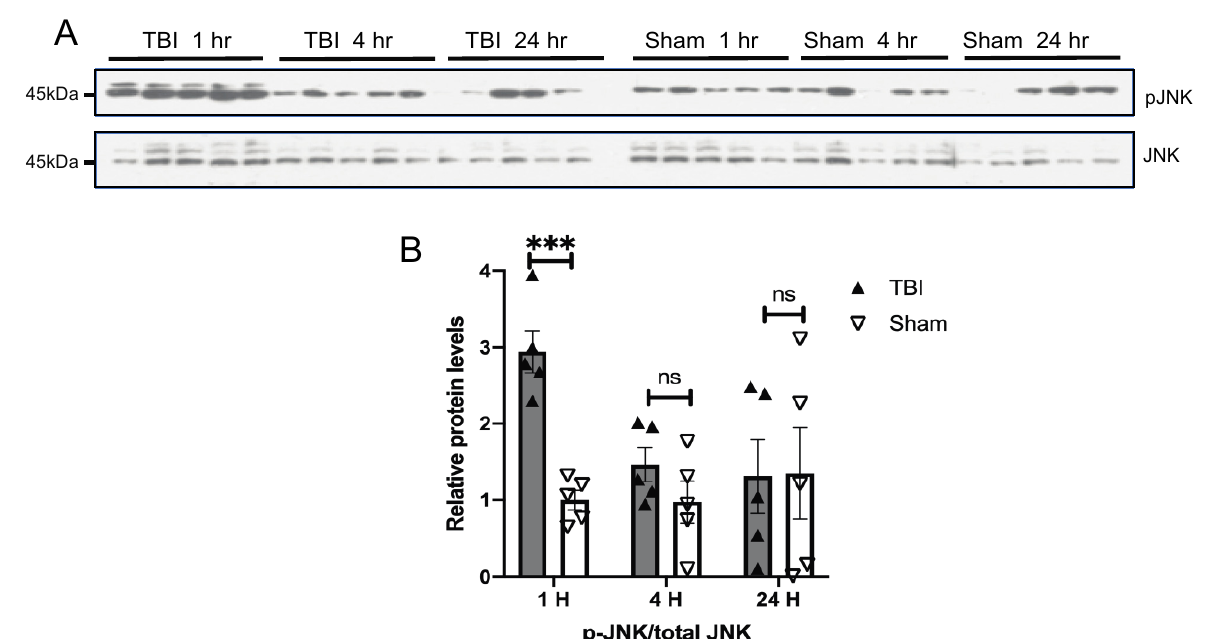
Figure 5. BOP caused the activation of c-Jun N-terminal kinase (JNK) in the mouse brain. Representative Western blots ( A ) and quantification analysis ( B ) revealed the activation of JNK after blast ( n = 5/group). (Data are means ± SEM, *** p < 0.001; ns, non-significant). pJNK: phospho-JNK.